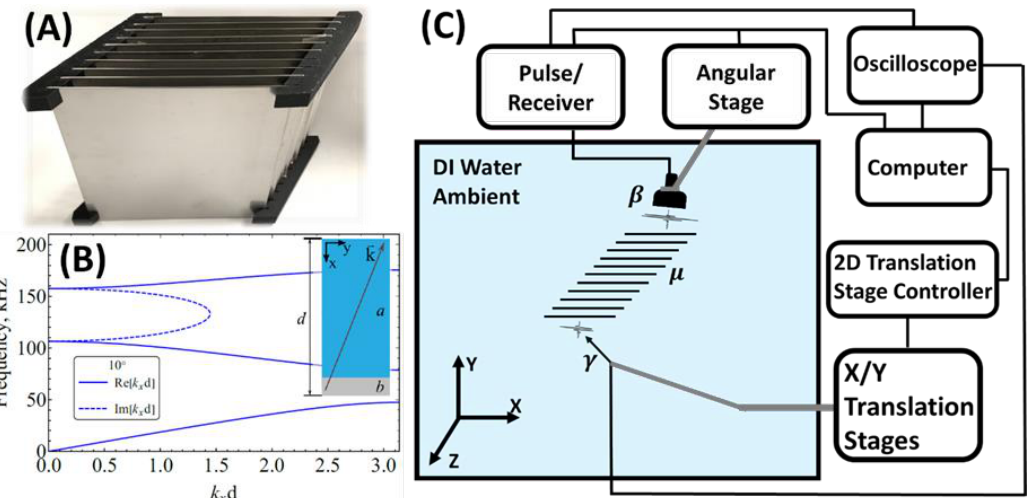
Figure 1. Design of the 10 layers superlattice structure. ( A ) Photograph of the real fabricated superlattice structure. The corner holders were made by water-property-like resin. ( B ) The band structure calculated for 10 ◦ angle of incidence. ( C ) Schematic diagram of the experimental setup. In the figure, β refers to the single element planar transducer with 100 kHz fundamental frequency, µ indicates the 10-layer superlattice structure, and γ is the needle type underwater